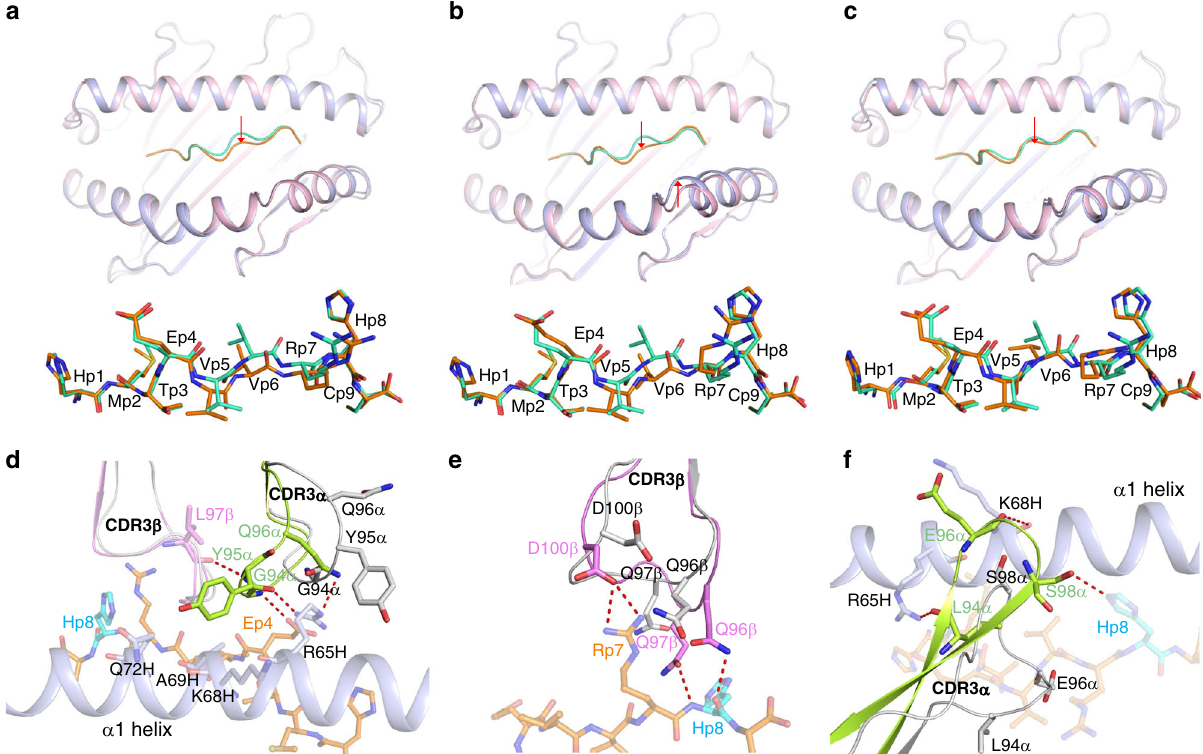
Fig. 7 Conformational changes in p53R175H – HLA-A2 and TCRs after complex formation. a (upper) Superposition of p53R175H – HLA-A2 in unbound form (peptide, green; HLA-A2, pink) and in complex with TCR 12-6 (peptide, orange; HLA-A2, light blue). Red arrow indicates region of structural shifts. (lower) Close-up showing residue shifts induced by TCR 12-6 binding. Note that where orange sticks appear behind green sticks, the peptide has shifted deeper into the pocket. b Similar superpositions showing peptide and HLA shifts on binding TCR 38-10. c Similar superpositions showing conformational changes induced by binding TCR 1a2. d Structural rearrangements in CDR3 α of 12-6 induced by binding to p53R175H – HLA-A2 (bound 12-6, green or violet; unbound 12-6, gray; p53R175H, orange; HLA-A2, light blue). e Structural rearrangements in CDR3 β of 1a2 induced by binding to p53R175H – HLA-A2. f Structural rearrangements in CDR3 α of 1a2 induced by binding to p53R175H –